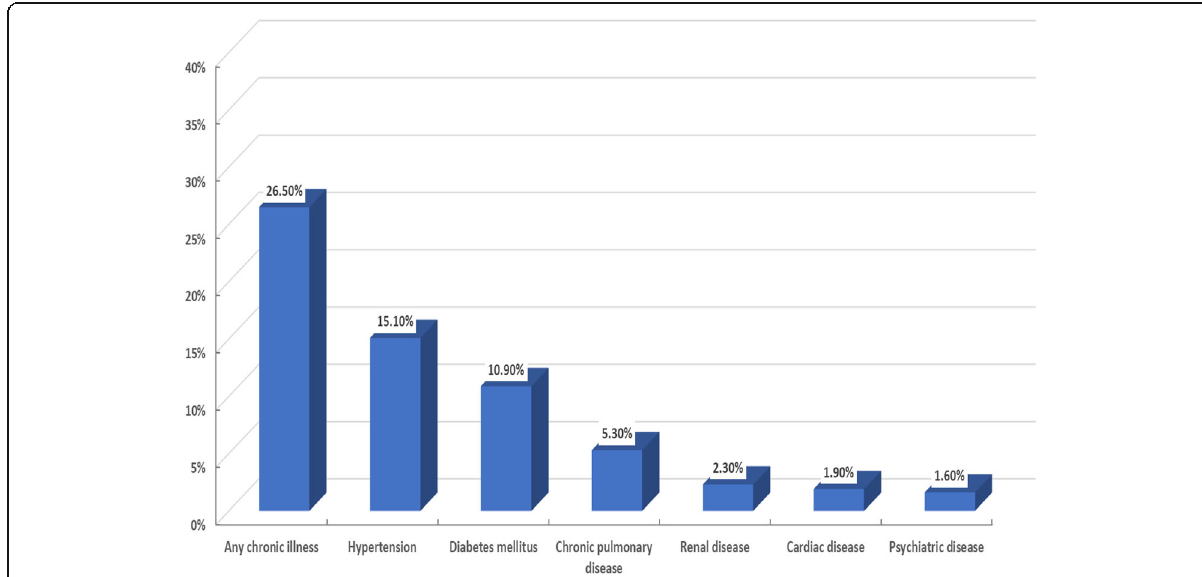
Fig. 2 Associated comorbidities in post-COVID-19 patients included in the study ( n = 430)